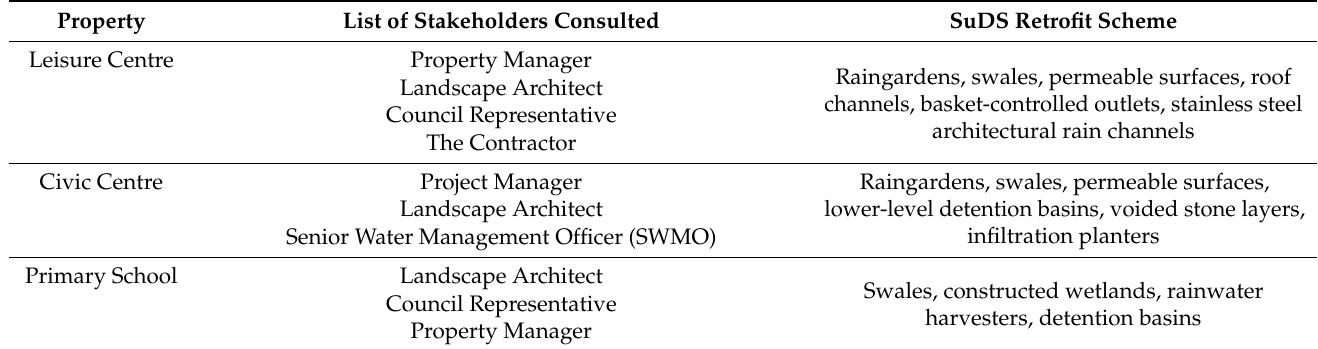
Table 1. Stakeholder and SuDS